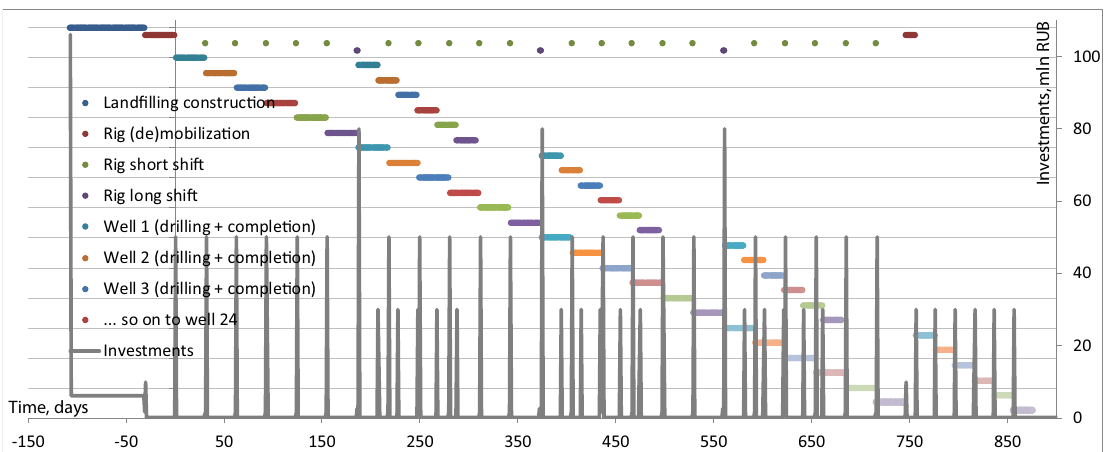
Fig. 7 Scenario 2 reference design well pad production and NPV profiles